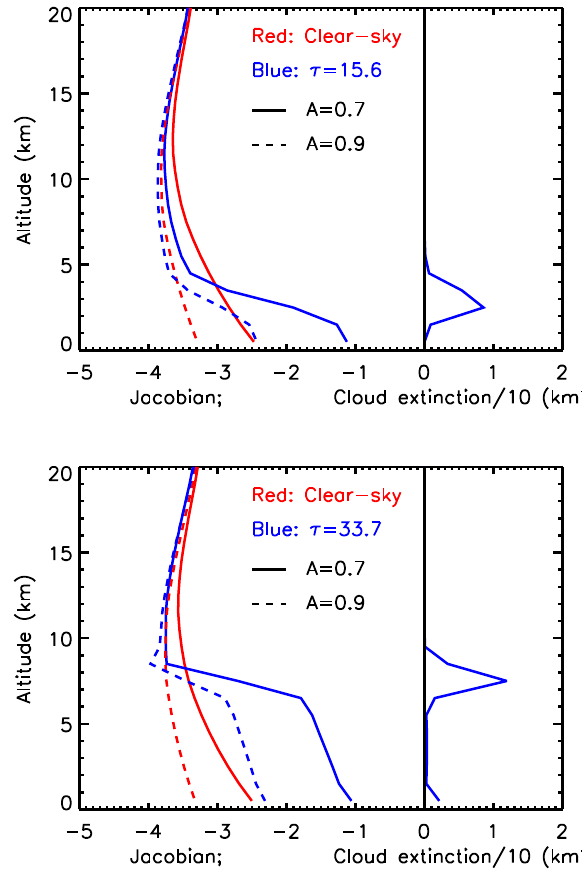
Fig. 5. Jacobians (derivative of natural log of radiance with respect to the ozone optical depth) (left) computed for two different (top and bottom) CloudSat / MODIS cloud extinction profiles (right) and two values of surface albedos A .